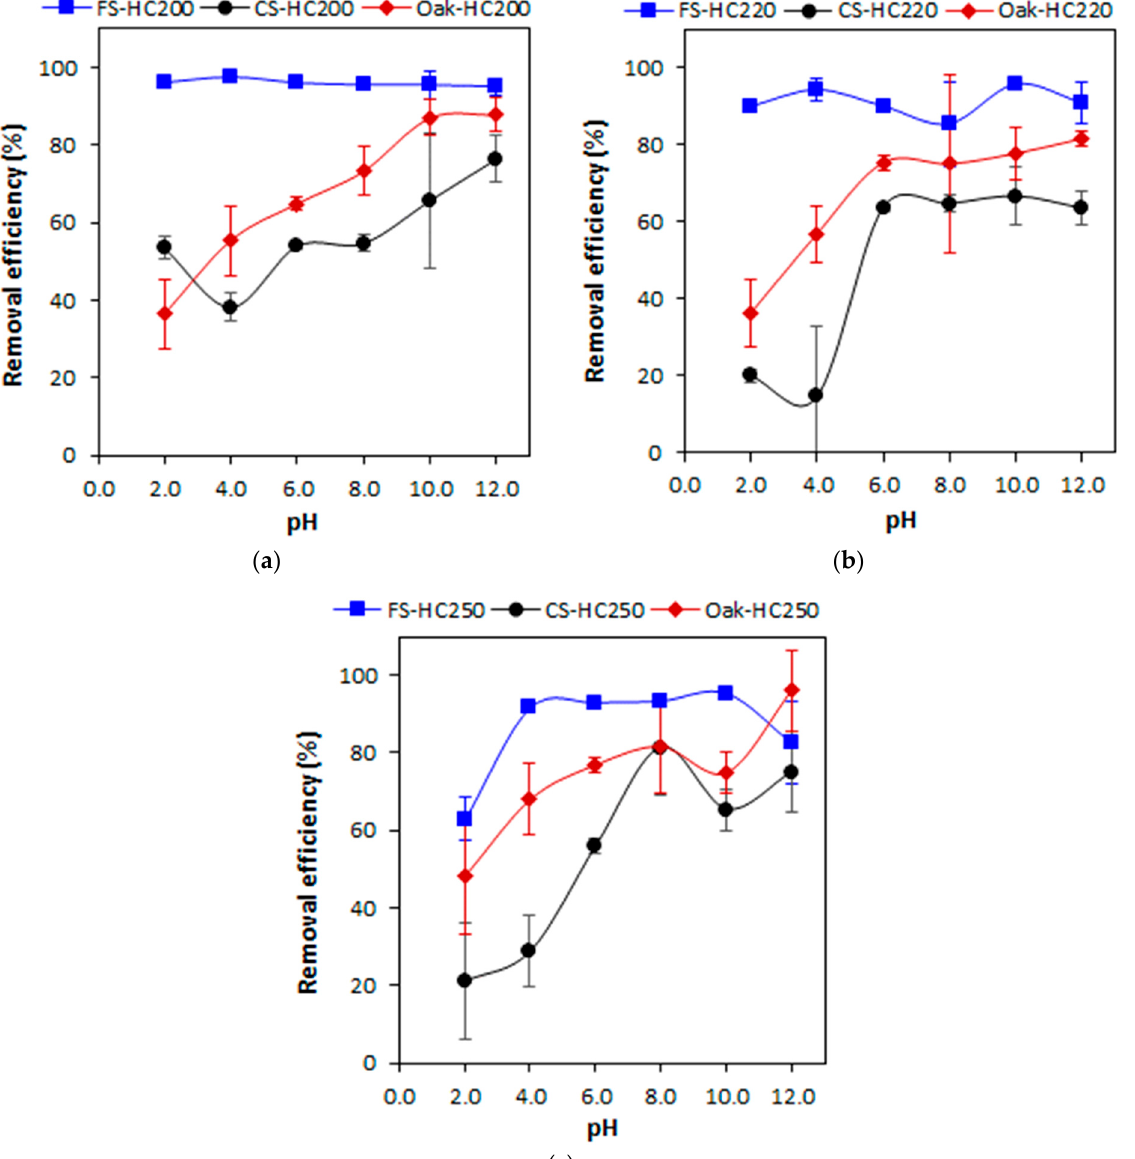
Figure 3. Effect of solution pH and HTC temperature on adsorption removal efficiency of hydrochars derived at ( a ) 200 °C; ( b ) 220 °C; and ( c ) 250 °C.